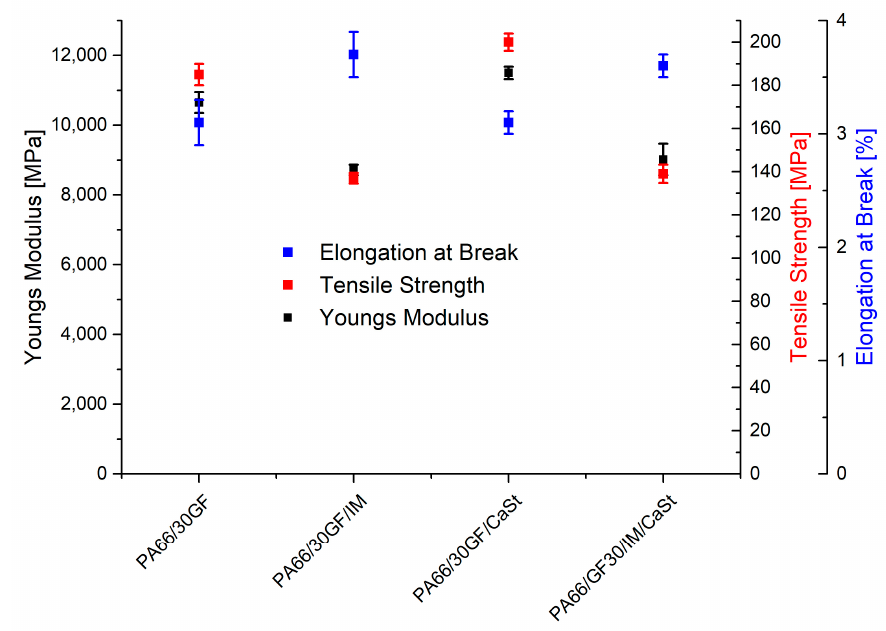
Figure 3. Results of tensile test with PA66/30GF-based specimen.